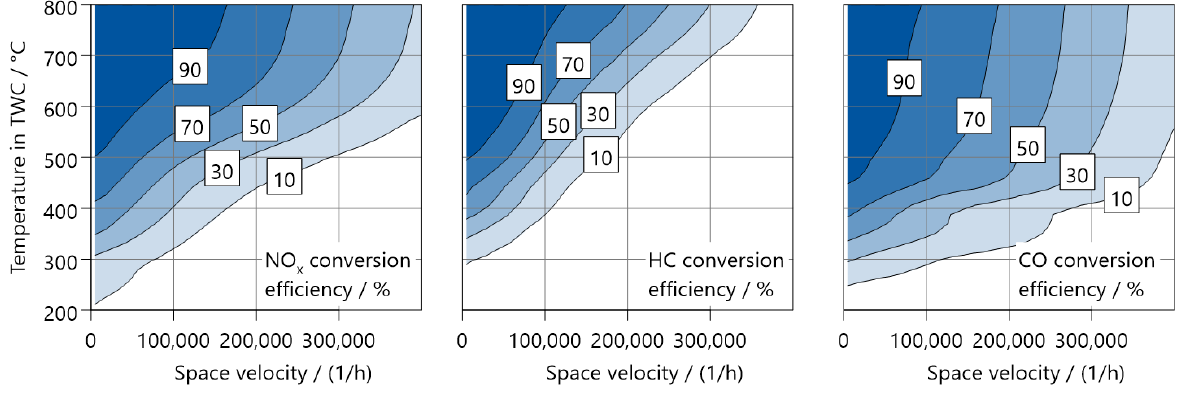
Figure 2. Conversion efficiency maps of an aged Euro6d-TEMP three-way catalyst [19].